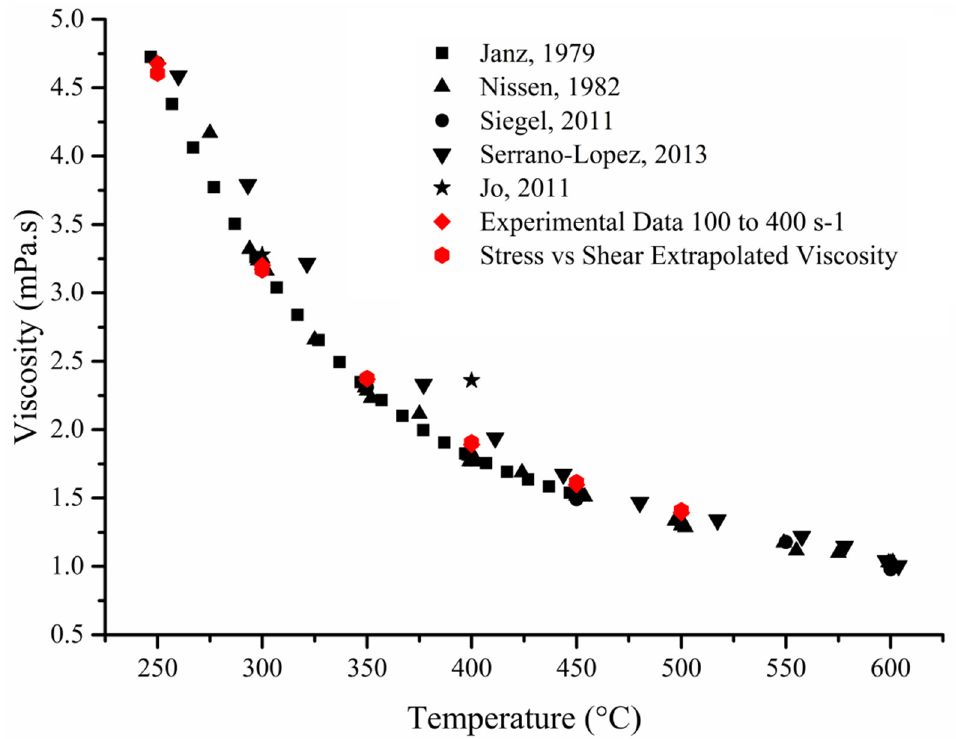
Figure 1. Digitised data taken from various publications [1–5] on the viscosity of eutectic mixture of sodium and potassium nitrate (60/40 ratio) against data acquired on the viscometer and extrapolated from gathered